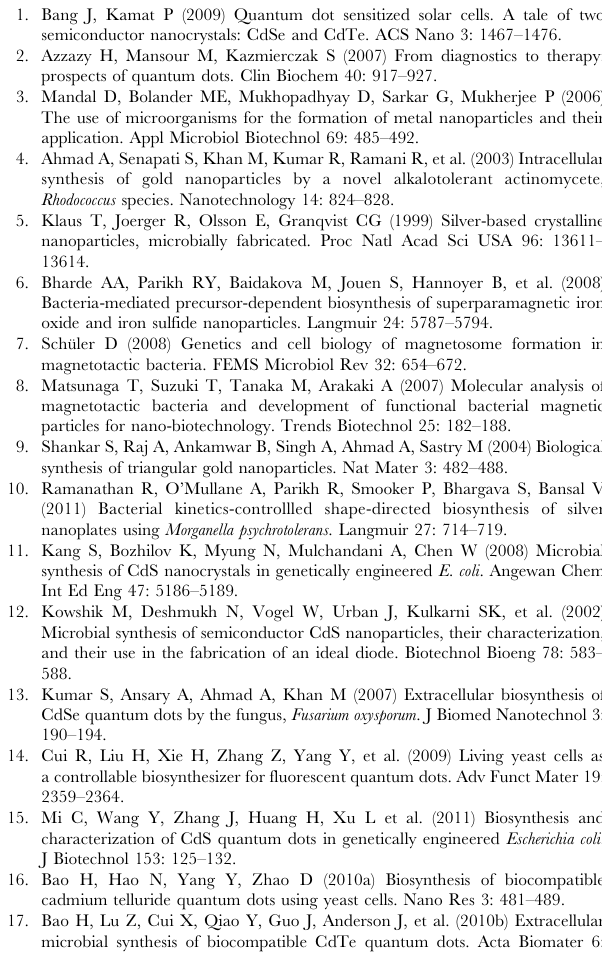
Figure S1 GshA and GshB induction kinetics. SDS-PAGE analysis of total proteins from E. coli AG1 and E. coli gshA after IPTG (0.5 mM) treatment for the indicated times.